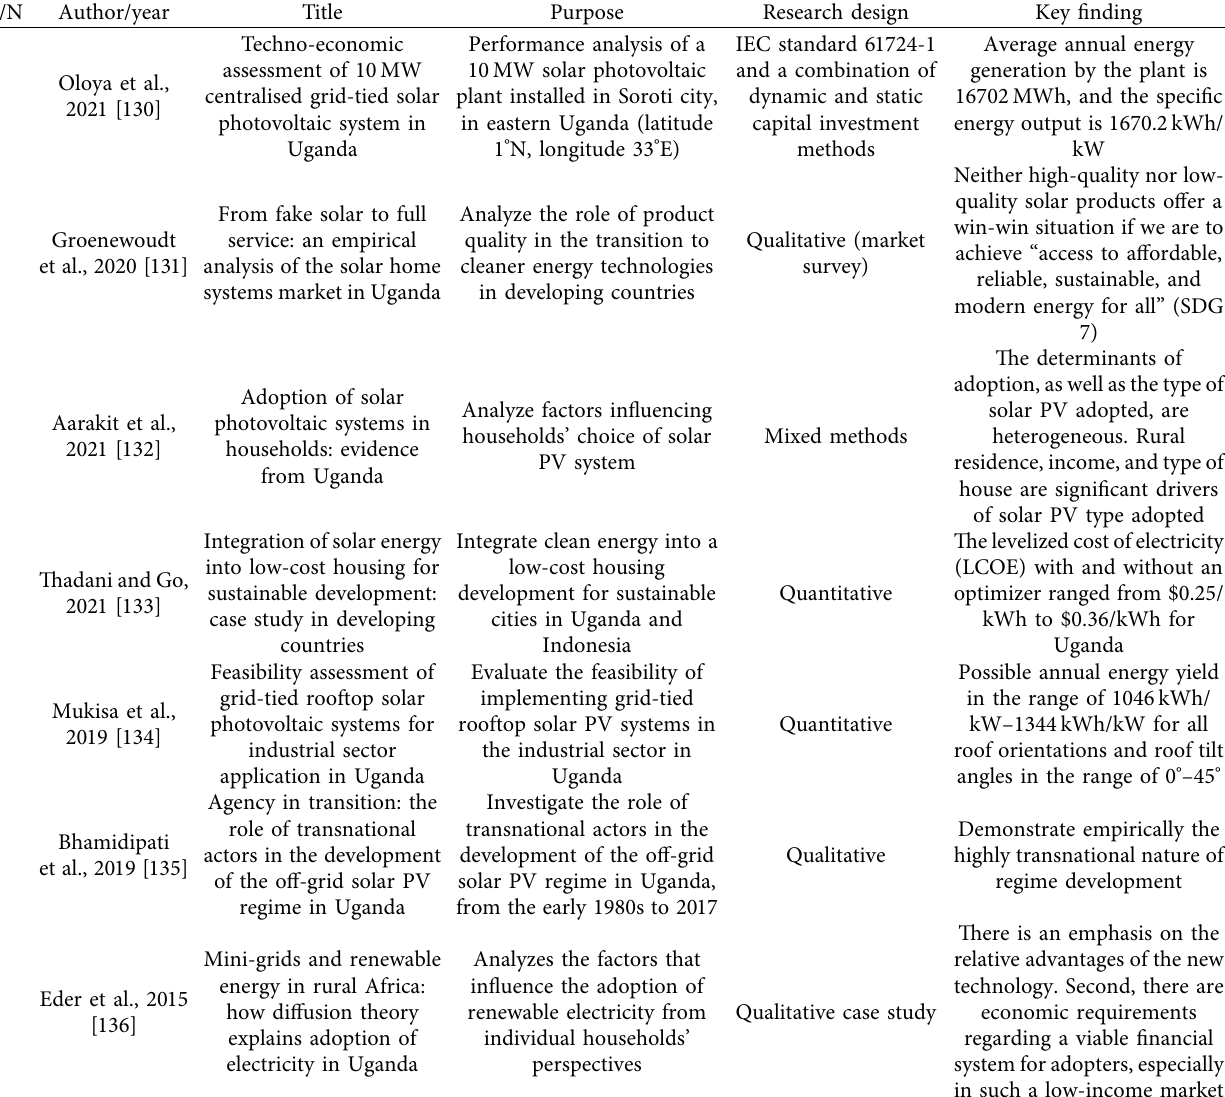
Table 9: Summary of literature on solar energy in